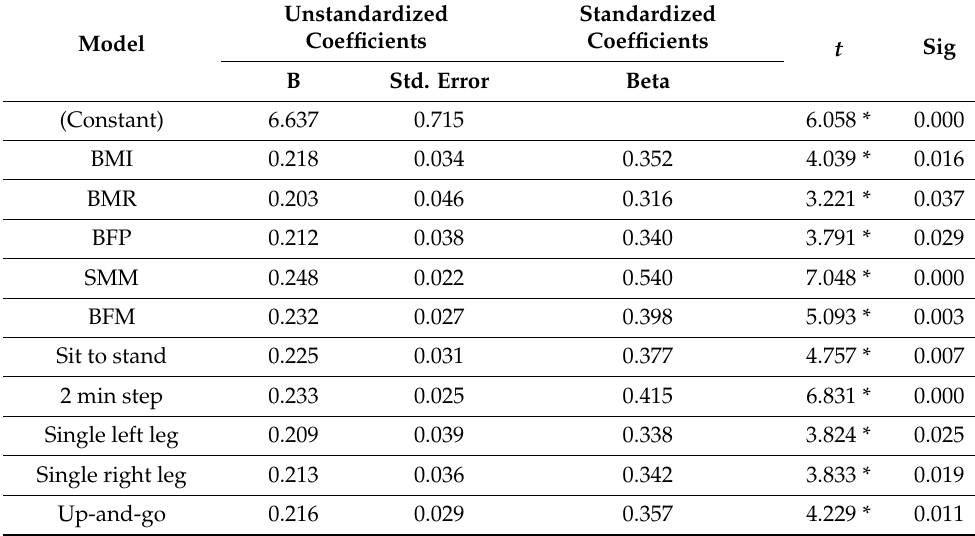
Table 9. GS coefficients for multiple regression model